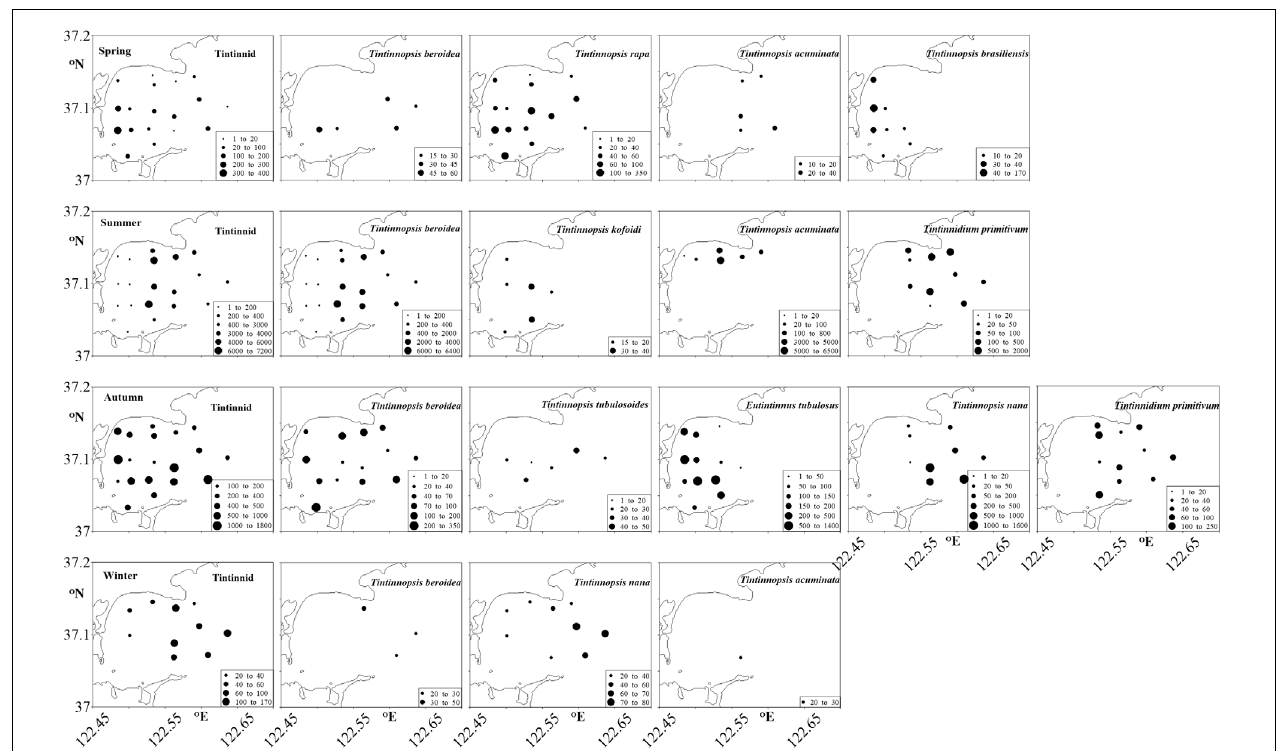
FIGURE 4 | Tintinnid and main species abundance (ind. dm − 3 ) surface distribution in four successive seasons, spring to winter.